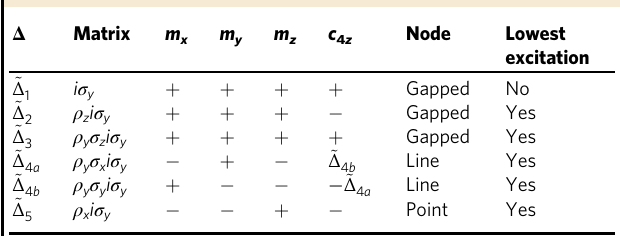
Table 2 Properties of time-reversal-symmetric constant pairing functions in a 2D model of FeSe at Γ